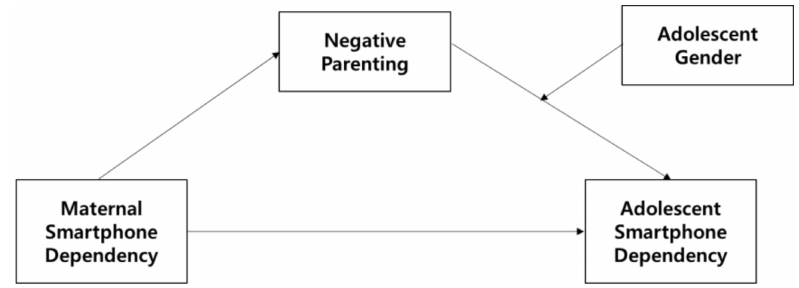
Figure 1. Conceptual framework of the current